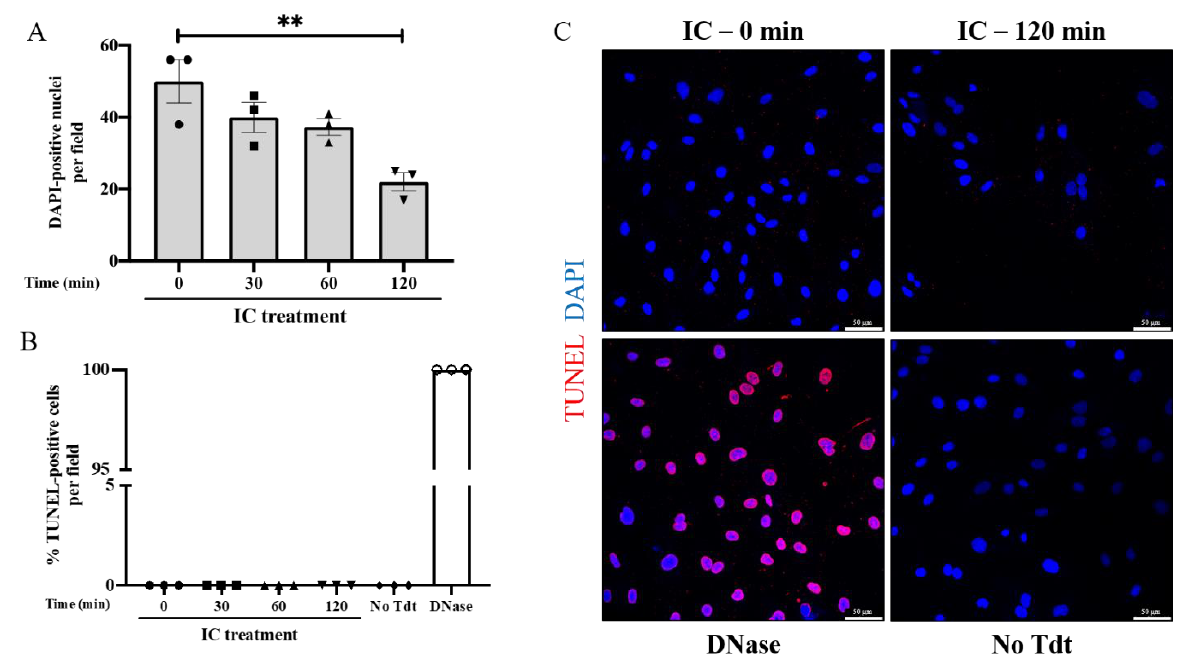
Figure 2. IC treatment does not cause apoptosis. Type O HPAEC treated with serum-derived IC 1:1 with media for 0, 30, 60, or 120 min. TUNEL staining was performed to mark the nuclei of apoptotic cells and DAPI was used to mark nuclei, with DNase treatment as a positive control and no Tdt as a negative control. ( A ) The number of DAPI-positive nuclei per field was averaged for each treatment to quantify the number of cells. ( B ) The percentage of TUNEL-positive cells per field for IC treatments of 0, 30, 60, and 120 min, no Tdt, and DNase controls was reported by quantifying the number of cells with TUNEL-stained nuclei normalized to the number of DAPI-stained cells per field. Note: no positive cells were seen in IC 0, 30, 60, 120, and No Tdt. ( C ) Representative images from 0 min, 120 min, DNase, and no Tdt treatments with TUNEL staining (red) and DAPI staining (blue). Data are mean + SE (n = 3 fields per condition) and were analyzed by one-way ANOVA. p -values as follows: ** p < 0.01.